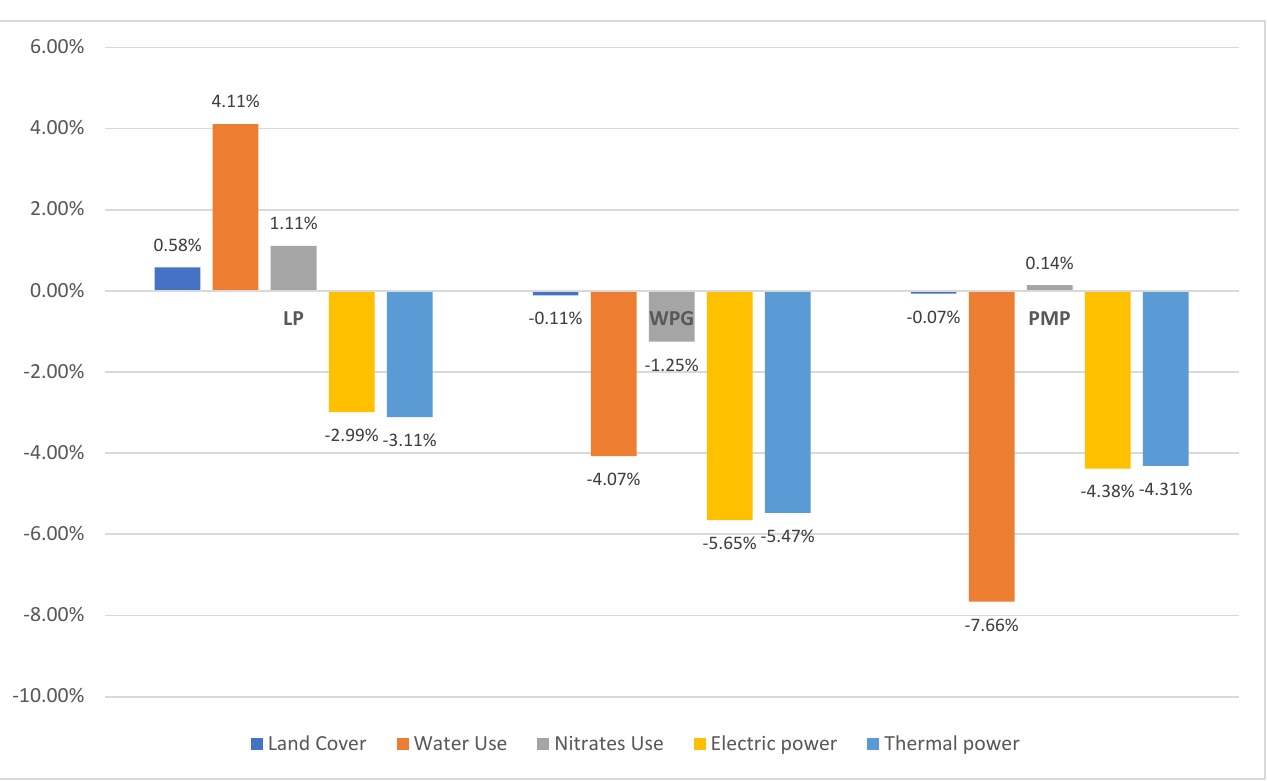
Figure 5. Changes in Environmental Indicators. Source: Our elaboration.